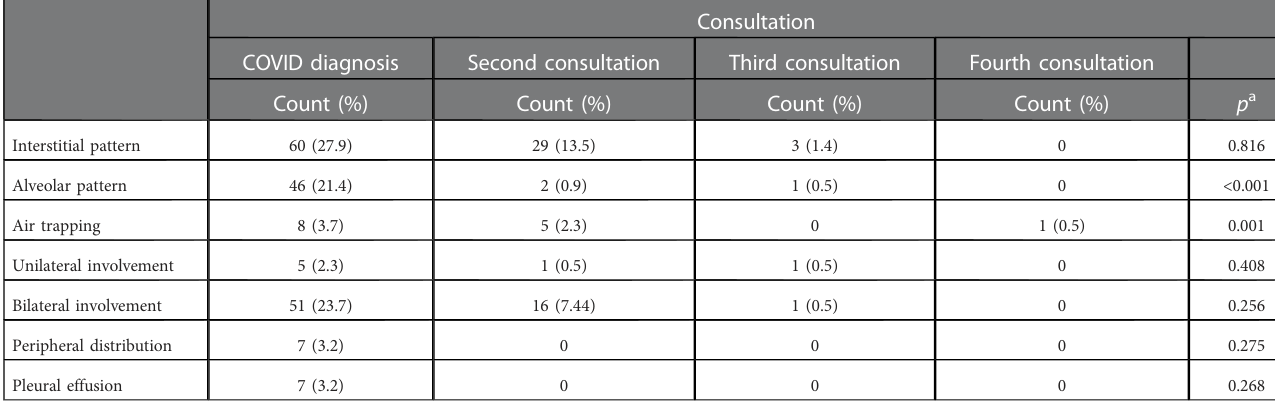
TABLE 3 Radiological alteration at diagnosis and follow-up